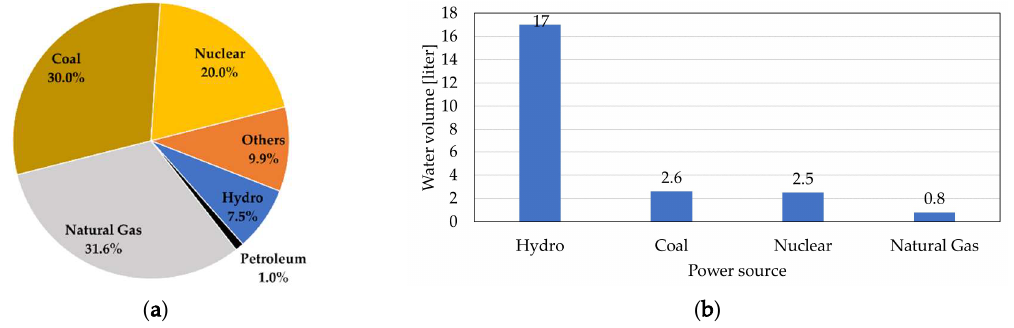
Figure 3. USA energy matrix and water consumed to generate 1 kWh of electricity. ( a ) USA energy matrix (ASHRAE—American Society of Heating, Refrigerating and Air-Conditioning Engineers), ( b ) water consumed to generate 1 kWh of electricity [9].